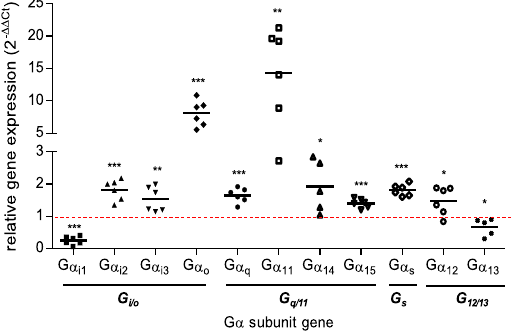
Figure 1. Quantification of heterotrimeric G protein α subunits gene expression levels in hypertrophic cardiomyocytes. Comparative analysis of G α subunit gene expression of the four G protein families (G i/o , G q/11 , G s , G 12/13 ) in total RNA extracts from cardiomyocytes isolated from mice exhibiting or not (control) transversal aortic banding (TAC) obtained by Fluidigm Real-time qPCR. Results are expressed as the relative induction of the genes in C57Bl/6 mice submitted to TAC for 15 days (n = 6) compared to control mice (n = 6) wherein genes expression are equal to 1. The statistical significance of the change in expression level was assessed using unpaired Student’s t-test. * P < 0.05, ** P < 0.01, *** P <